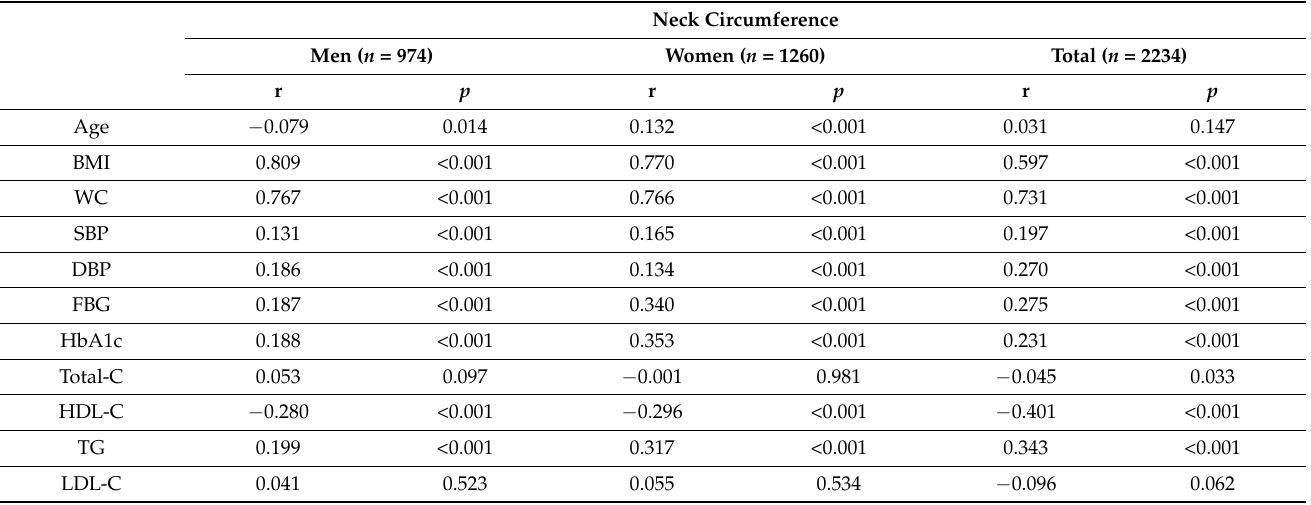
Table 3. Correlation analysis between NC and MetS components and its risk factors by sex.